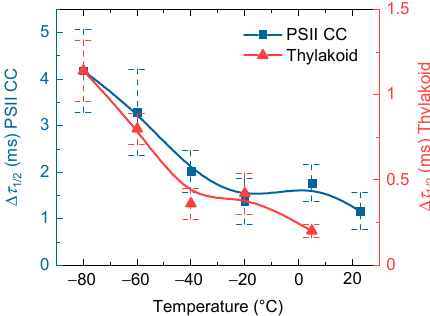
Figure 4. Temperature dependence of the double-STSF induced ( F 1 -to- F 2 ) ∆ τ 1/2 half-waiting times of isolated T. vulcanus PSII CC (blue) and spinach TMs (red). The data points are taken from Table 1. The continuous lines represent spline interpolation of the data points.